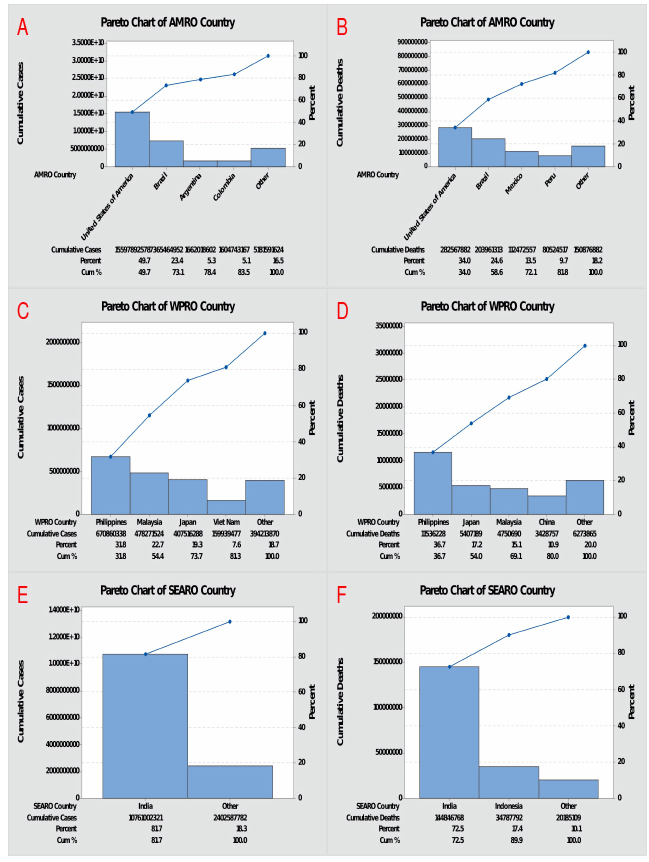
Figure 2. Pareto chart showing major countries in mortalities and morbidities from COVID-19 from AMRO (A and B), WPRO (C and D) and SEARO ( E and F),